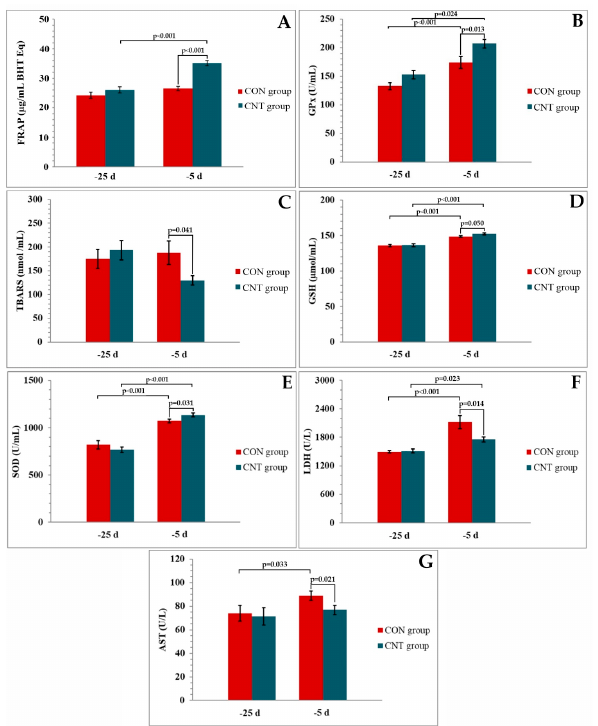
Figure 2. Activities of ( A ) total antioxidants (FRAP), ( B ) glutathione peroxidase (GPx), ( E ) superoxide dismutase (SOD), ( F ) lactate dehydrogenase (LDH), and ( G ) aspartate aminotranspherase (AST), and concentrations of ( C ) thiobarbituric acid reactive substances (TBARS) and ( D ) reduced gluta- thione (GSH) in serum of CON and CNT groups of cows at 25 and 5 days before expected parturi- tion. Values are expressed as mean ± SE. ( A ) Effects of treatment ( p < 0.001), time ( p < 0.001), and interaction between treatment and time ( p < 0.001); ( B ) effects of treatment ( p < 0.01), time ( p < 0.001), and interaction between treatment and time ( p = 0.687); ( C ) effects of treatment ( p = 0.100), time ( p = 0.300), and interaction between treatment and time ( p = 0.221); ( D ) effects of treatment ( p = 0.271), time ( p < 0.001), and interaction between treatment and time ( p = 0.291); ( E ) effects of treatment ( p =